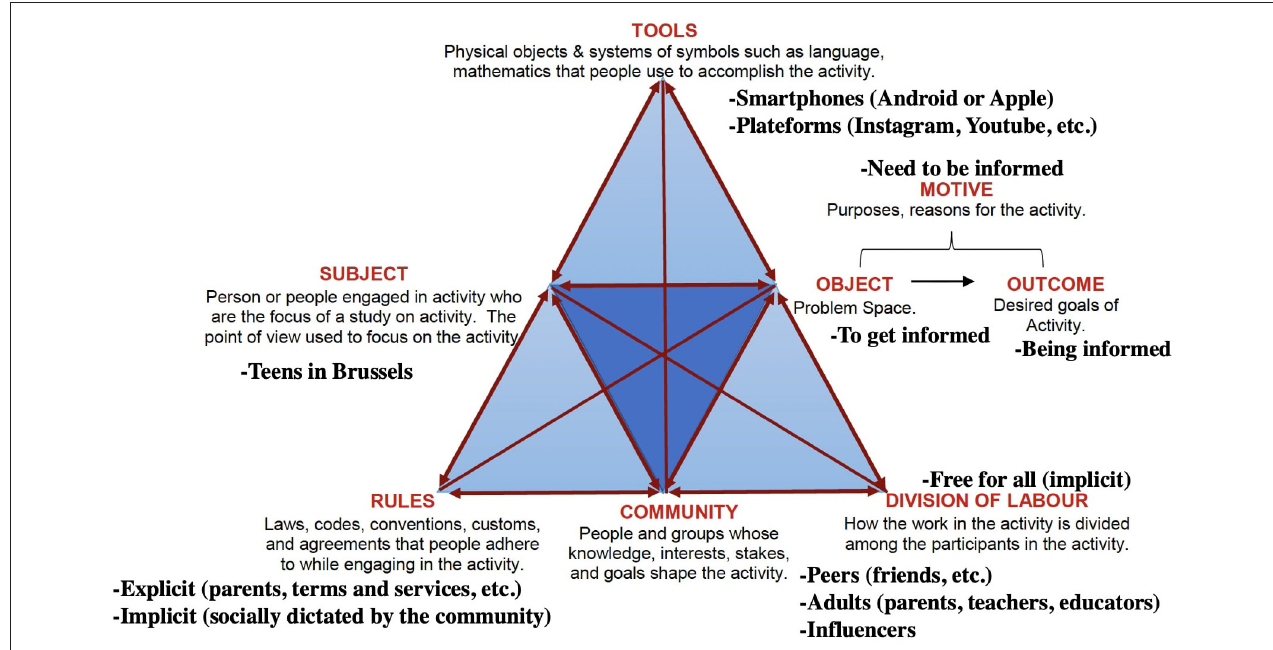
FIGURE 2 | Activity Theory: The pyramidal model, as applied to the context of this research (adapted from Engeström,